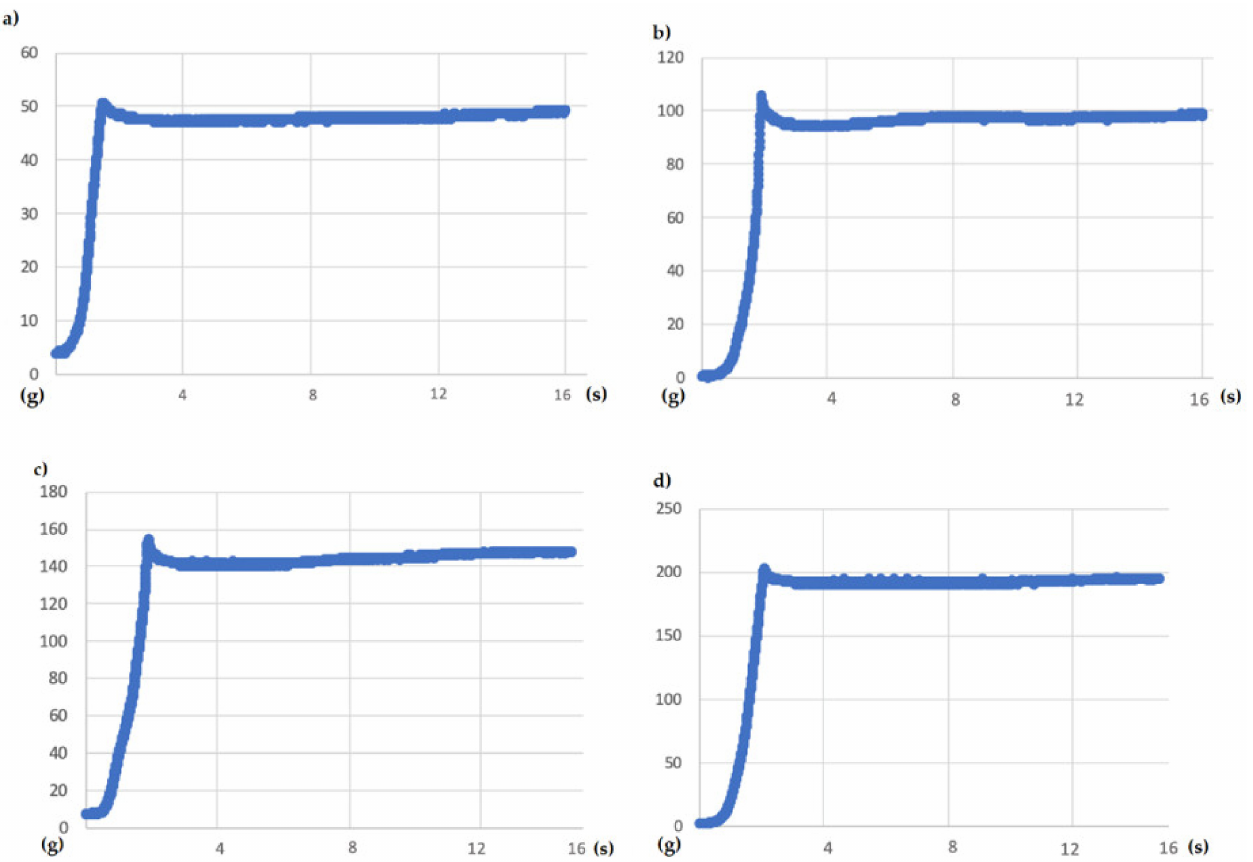
Figure 12. Weight vs. time graph for a 15 s test, and a demanded weight of ( a ) 50 g ( b ) 100 g ( c ) 150 g ( d ) 200 g. The existing initial peaks did not exceed 8 g of difference with the requested force, and the falls that followed them were not far from more than 8 g in any case